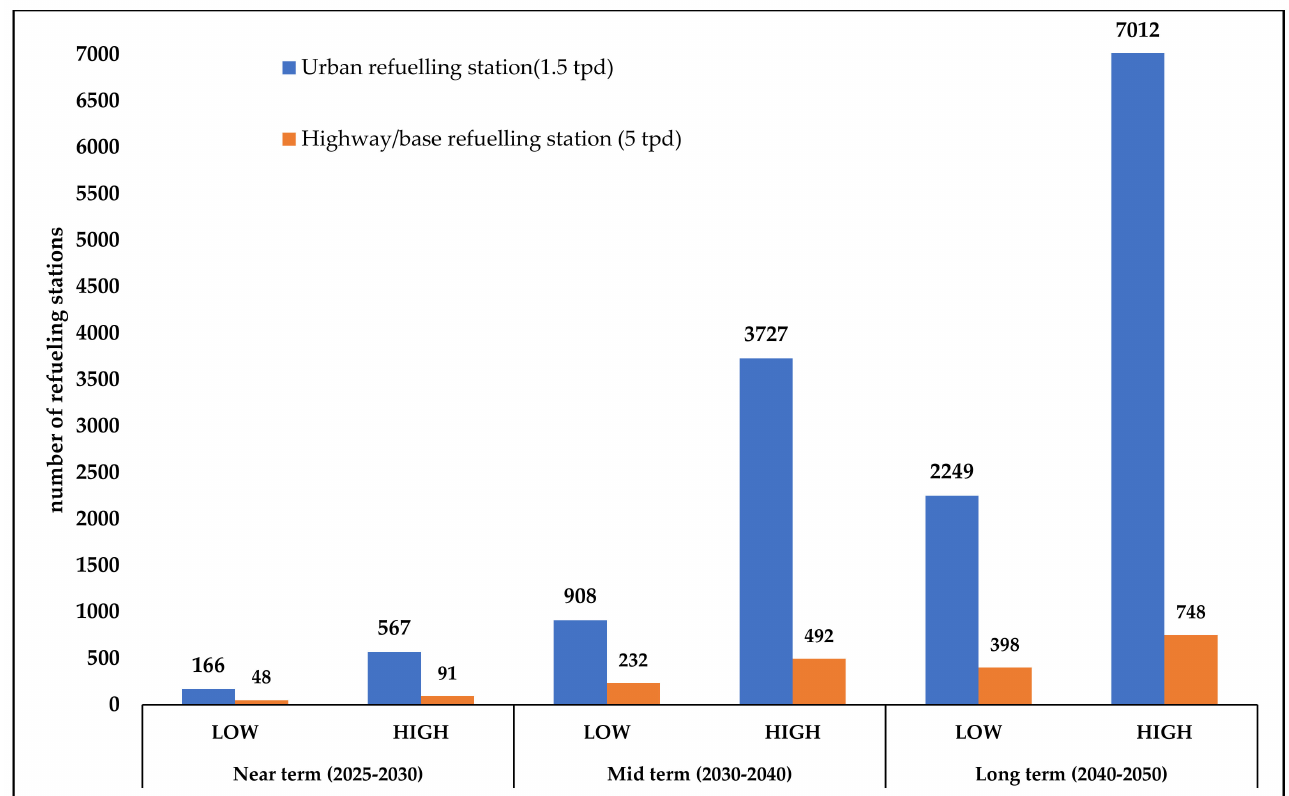
Figure 4. Projections for hydrogen refueling stations in California for different demand